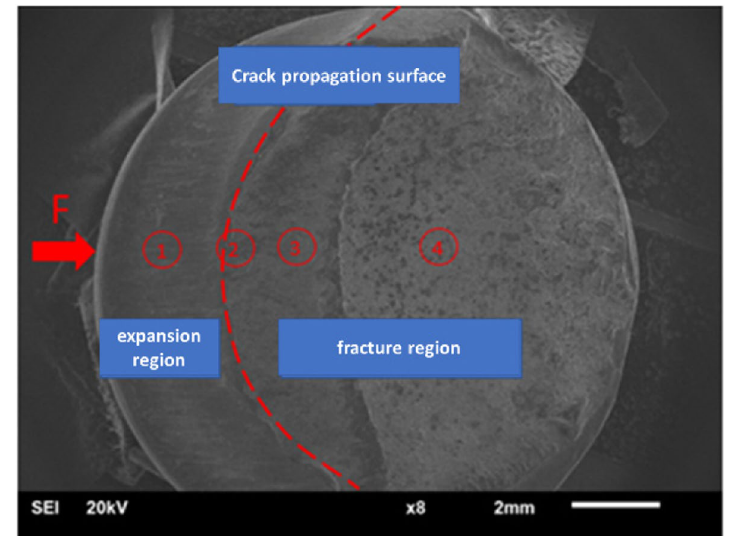
Fig. 11 Cross-section of the stud